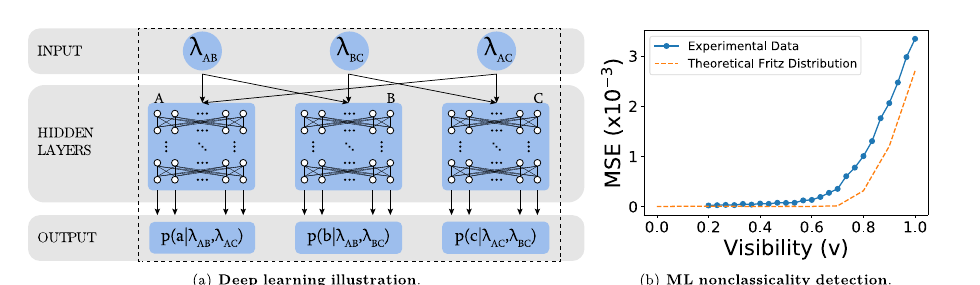
Fig. 4 | Neural network for the triangle network. a Neural network capable of reproducing distributions compatible with the triangle con fi guration, where number of layers varies from 3 to 6 and number of neurons is either 16 or 32, yielding 8 distinct architectures. The three sources λ AB , λ BC , and λ AC send informa- tion to three parties, Alice, Bob, and Charlie, each receiving, respectively, the pairs { λ AB , λ AC },{ λ AB , λ BC }, and { λ AC , λ BC }. b The minimum mean-square error (MSE)